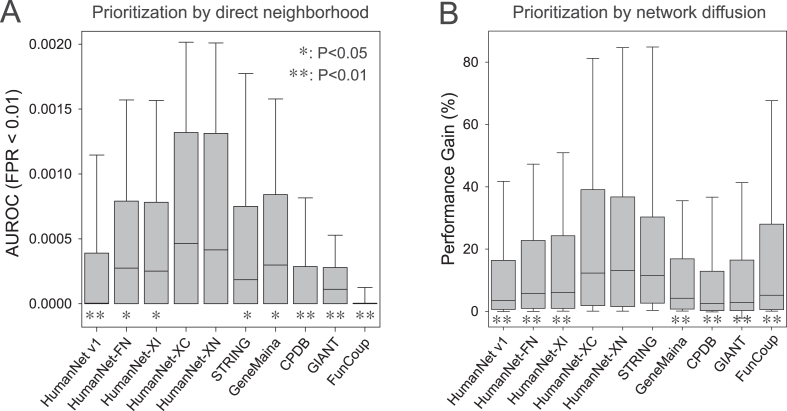
Assessment of predictive ability of networks for unbiased GWAS catalog disease gene sets based on the distribution of (A) the area under receiver operating characteristic curve (AUROC) until 1% of false positive rate (FPR < 0.01) and (B) performance gain scores based on area under precision recall curve (AUPRC). For each box-and-whisker plot, the boundaries of the box represent the first and third quartiles and the whiskers represent the 10th and 90th percentiles. Significance of performance difference from that of HumanNet-XC is indicated by asterisk (*: P < 0.05, **: P < 0.01, Wilcoxon rank sum test).